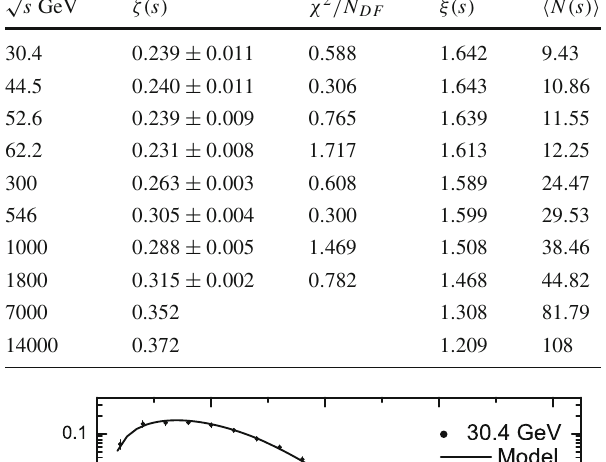
Table 1 Results reproduced from Ref. [19], where the P n phenomeno- logical procedure was applied √ s GeV